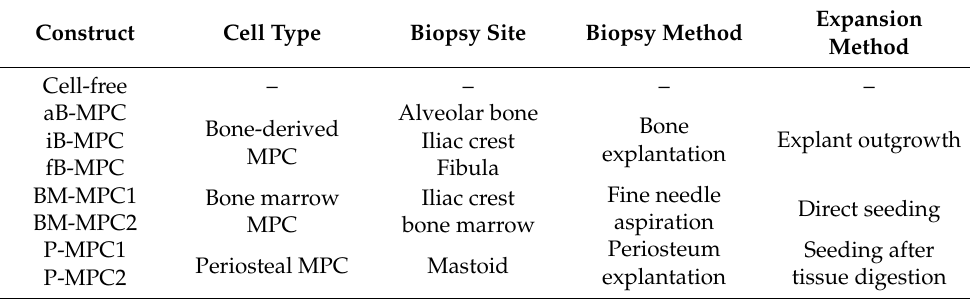
Table 1. Cell types used for